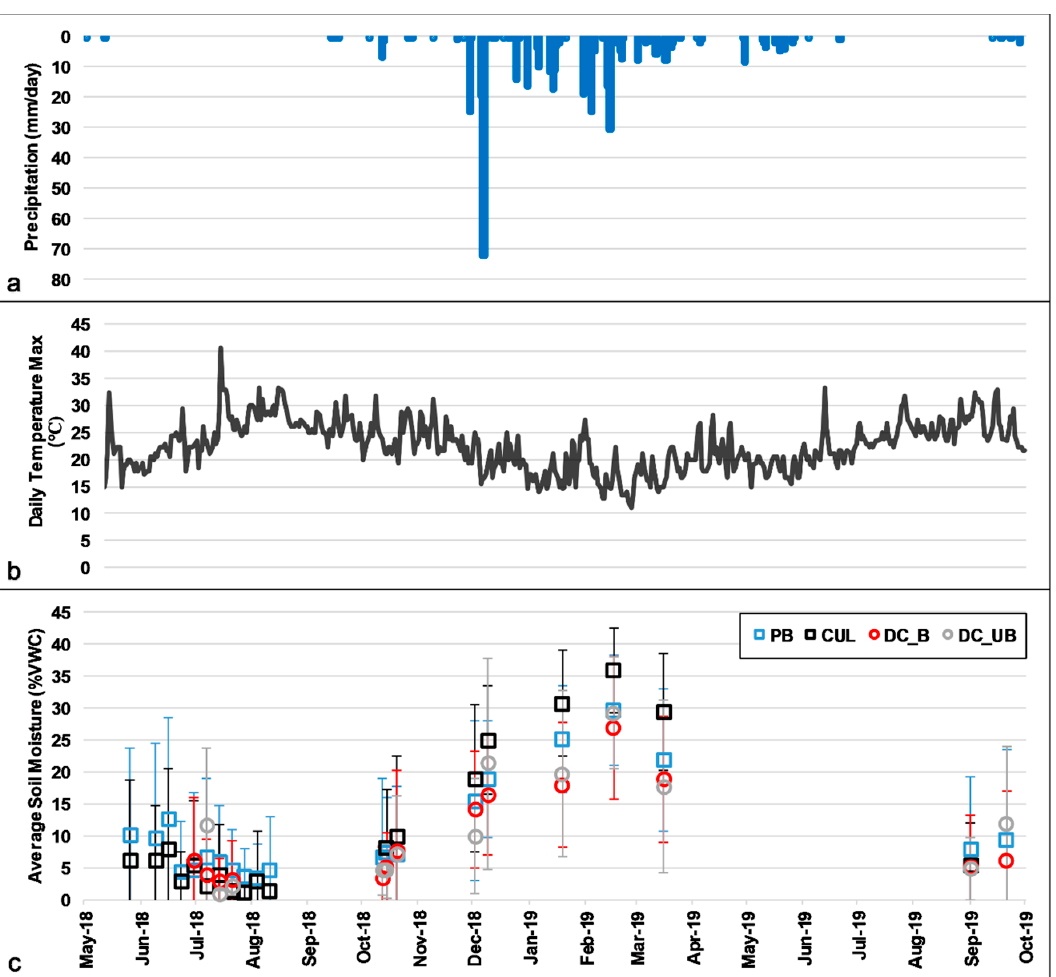
Figure 3. Daily precipitation (mm) ( a ), daily maximum temperature ( ℃ ) ( b ), and average soil